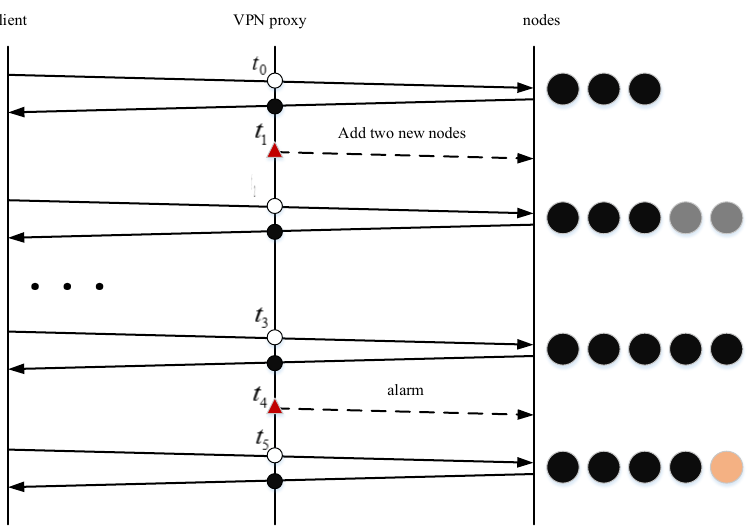
Figure 6. Schematic diagram of node status change. ( Black represents nodes with normal status, gray represents newly joined nodes, and orange represents the node with abnormalities.)